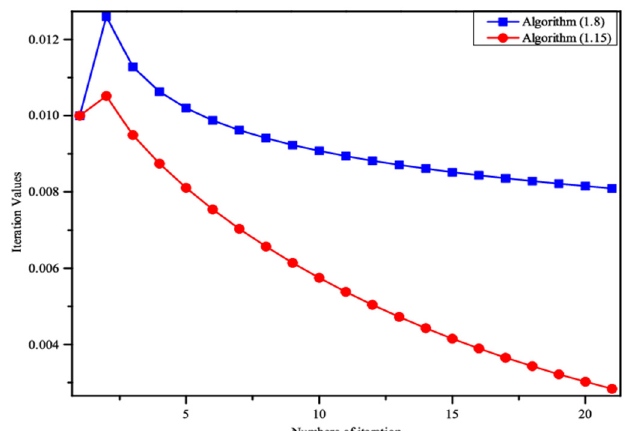
Figure 1. Comparison of the rate of convergence between iterative algorithms (8) and (15).